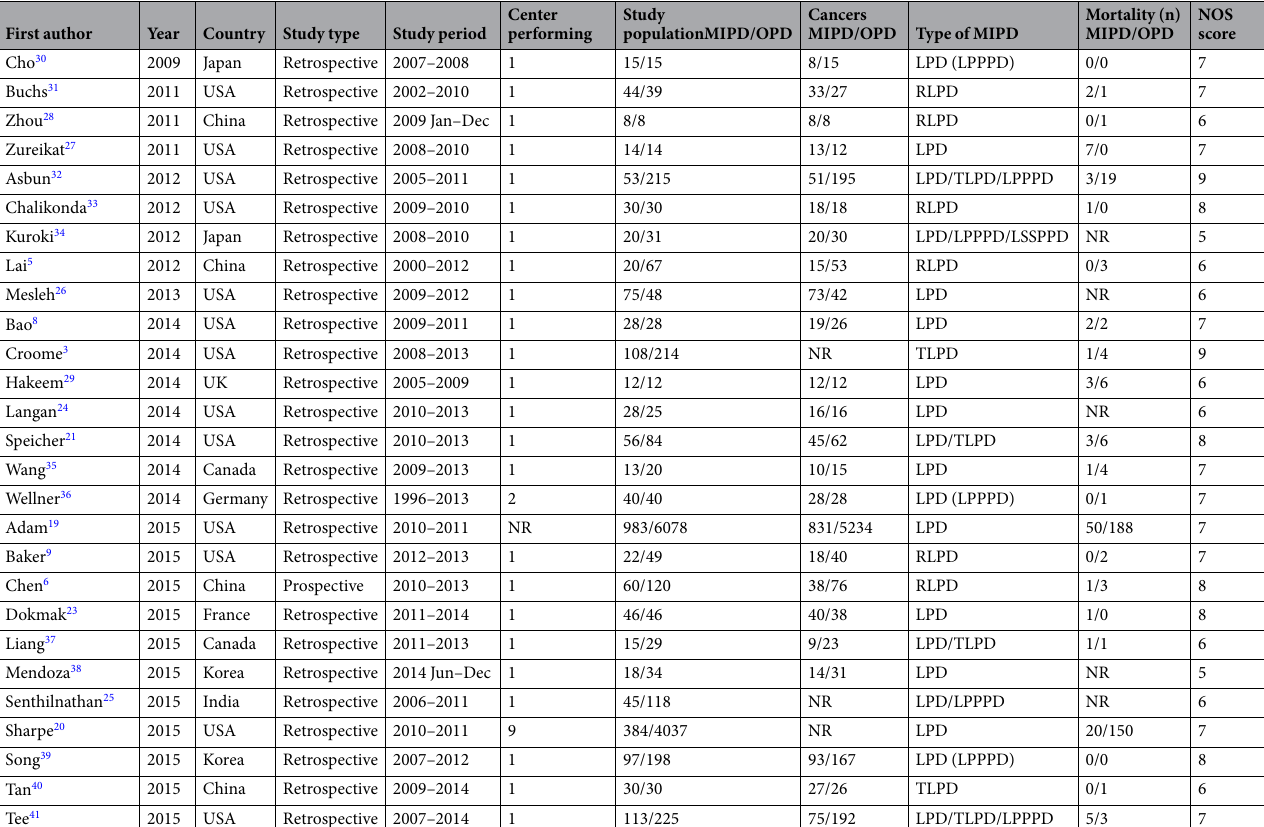
Table 1. Characteristics of included studies. MIPD: minimally invasive pancreaticoduodenectomy; OPD: open pancreaticoduodenectomy; LPD: laparoscopic pancreaticoduodenectomy; TLPD: total laparoscopic pancreaticoduodenectomy; LPPPD: laparoscopic pylorus-preserving pancreaticoduodenectomy; LSSPPD: laparoscopic subtotal stomach-preserving pancreaticoduodenectomy; RLPD: robotic-assisted laparoscopic pancreaticoduodenectomy; NOS: Newcastle-Ottawa Scale; NR: no